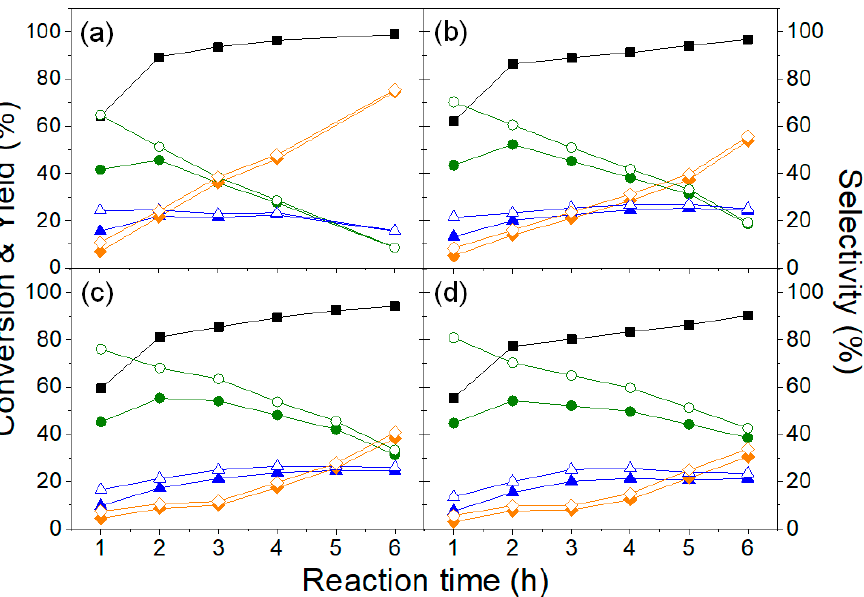
Figure 3. The influence of reaction time on the etherification reaction of glycerol in the presence of 3 wt.% of K-zeolite with ( a ) 0 wt.%, ( b ) 0.1 wt.%, ( c ) 0.2 wt.%, and ( d ) 0.3 wt.% of KHSO 4 (- ■ -: con-